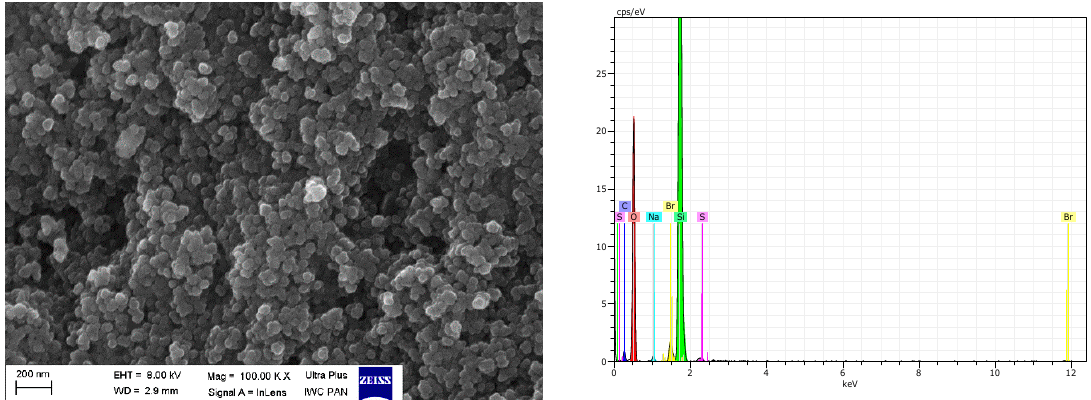
Figure 12. SEM with EDS analysis for VN3/IL20.